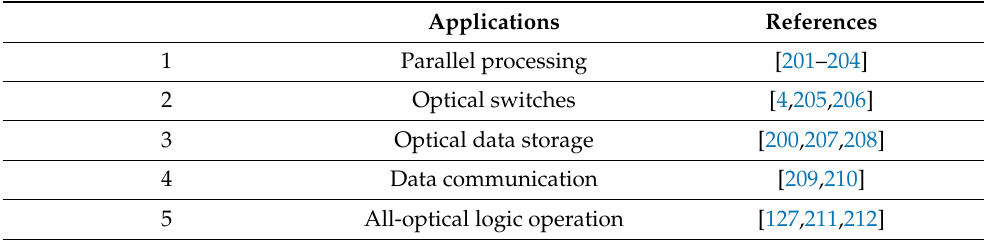
Table 3. Some important applications of